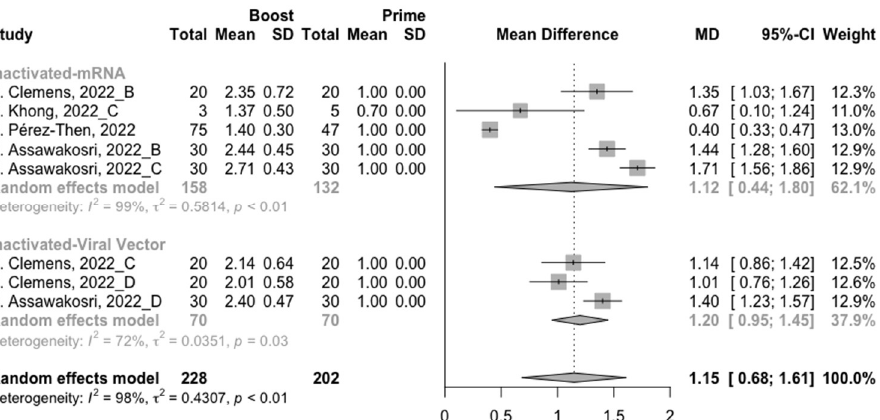
Figure 12. Forest plot of the pooled log-transformed neutralization titers against the Omicron vari- ant before and after heterologous booster vaccination.